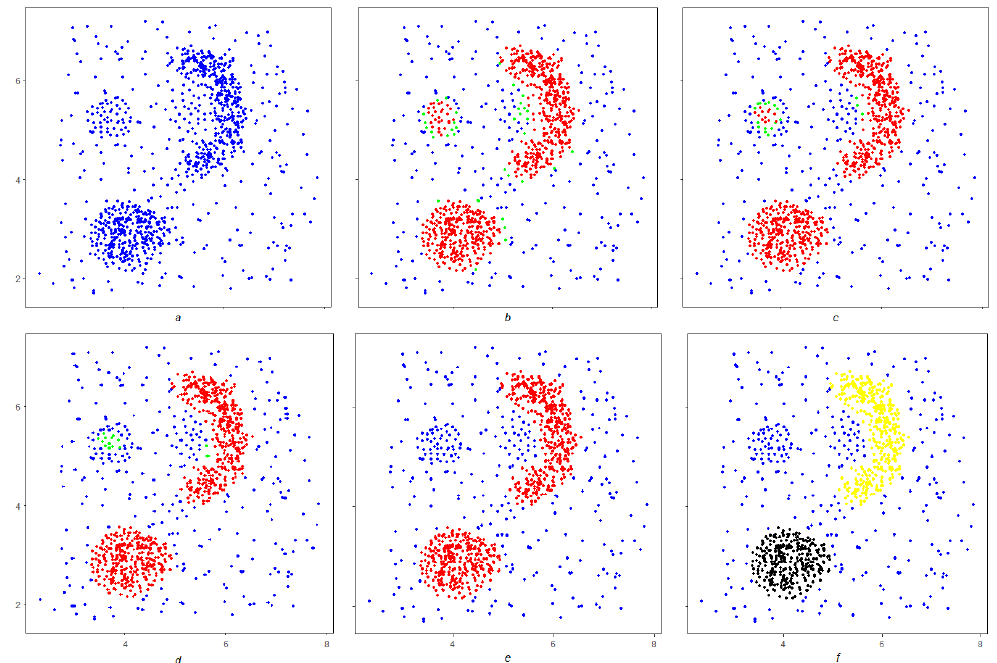
Figure 2. Application of the SDPS algorithm to the array X ( a ). Four iterations are shown in ( b – e ). The result is a local α -perfect subset of X ( α ) in X ( e ). The green points in figures ( b – d ) show the points that did not pass the next iteration in SDPS. SDPS further split X ( α ) into connected components (yellow and black subsets ( f )).